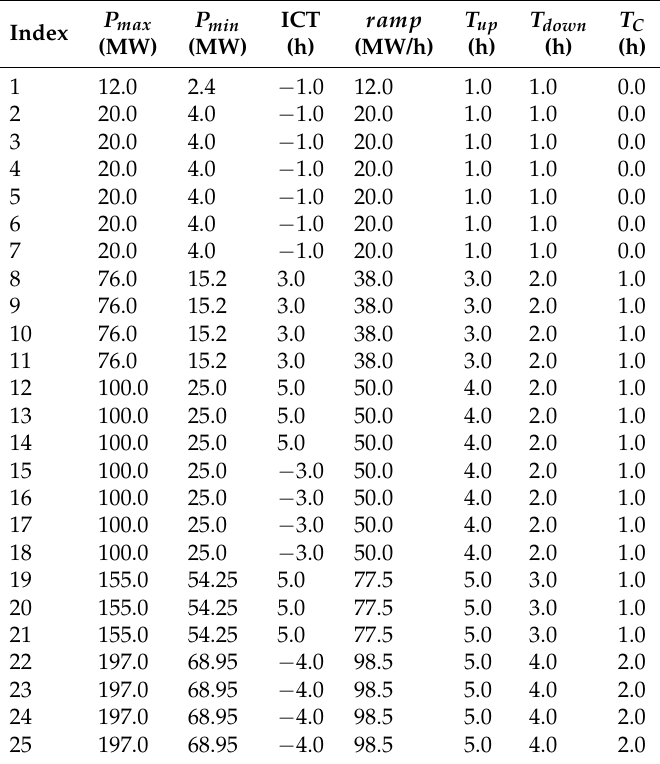
Table A2. 36 units system operation